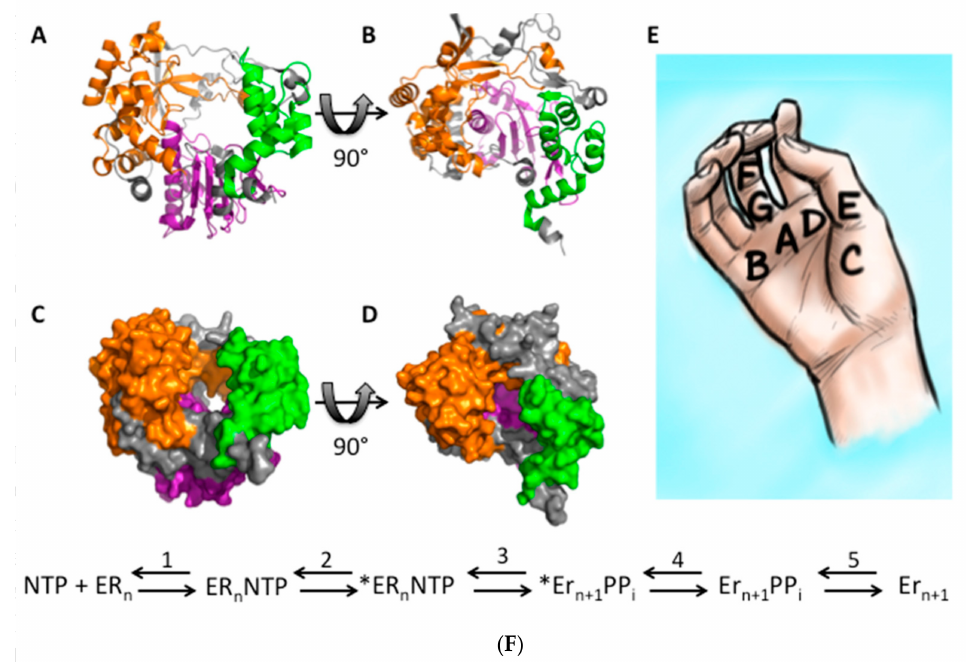
Figure 3. RdRp structure and RdRp kinetics. The FMDV RdRp structure [64] was downloaded from the RCSB PDB and visualized in PyMol v1.8.4.0 [65]. Structure ( A , B ) and surface models ( C , D ) are depicted. The RdRp is color-coded with the fingers as orange, the palm as purple, and the thumb as green. Location of conserved RdRp motifs as visualized on a right hand diagram ( E ). RdRp kinetics steps for NTP addition to an RNA chain ( F ). First, an NTP binds the RdRp, which causes a conformational change “*” (step 2) and activates the RdRp (step 3). The NTP is then added to the RNA chain, leading to another conformational change and translocation of the RNA (step 4). Finally, the PP i leaving group is released (step 5), allowing the cycle to begin